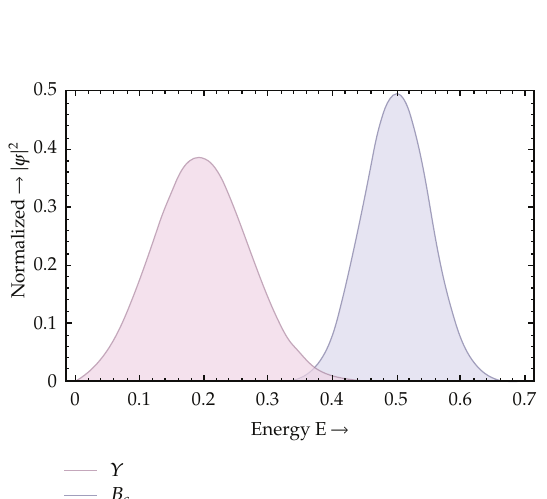
Figure 2: The overlap of wave functions for Υ → 𝐵 𝑐 decays at 𝜔 Υ = = 0.40 GeV. 𝜔 𝐵 𝑐